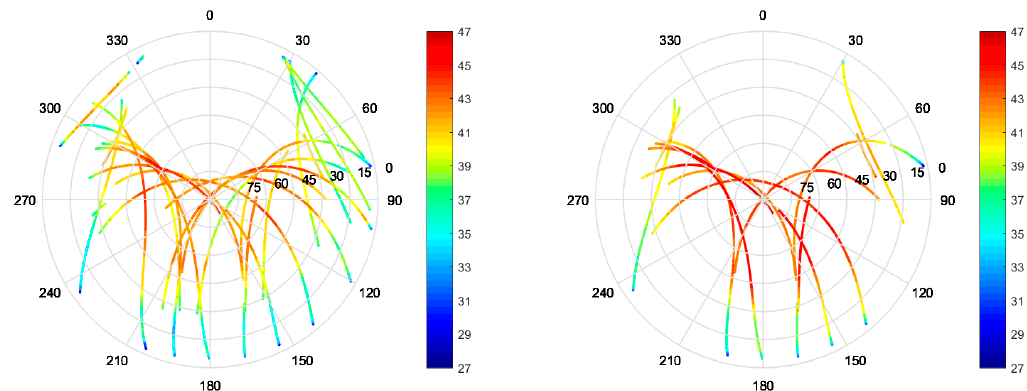
Figure 13. Sky plots of the recorded C/N0 values over the different satellite passes for L1/E1 ( left ) and L5/E5a ( right ).